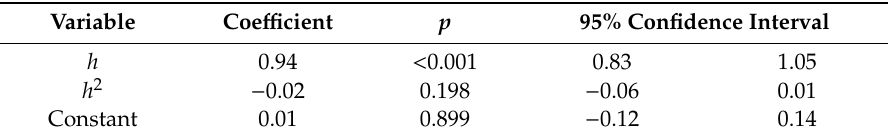
Table 6. Link test (first model).